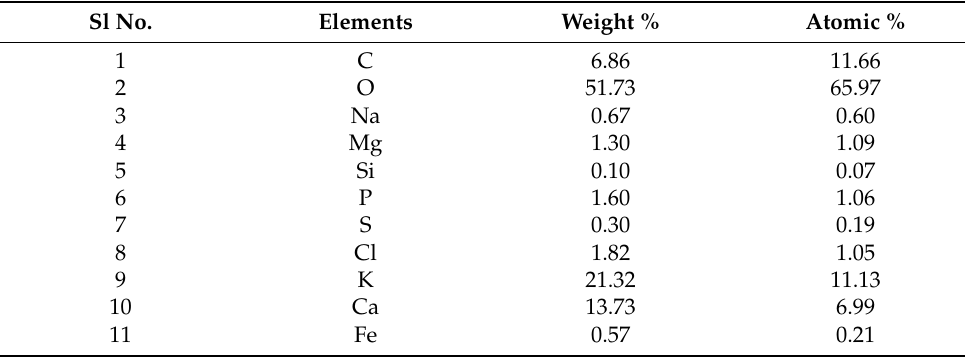
Figure 3. ( a ) Energy ‐ dispersive X ‐ ray spectroscopy (EDX) analysis of OPA, and ( b ) TGA thermogram of OPA. Table 2. EDX data for elemental composition of OPA.